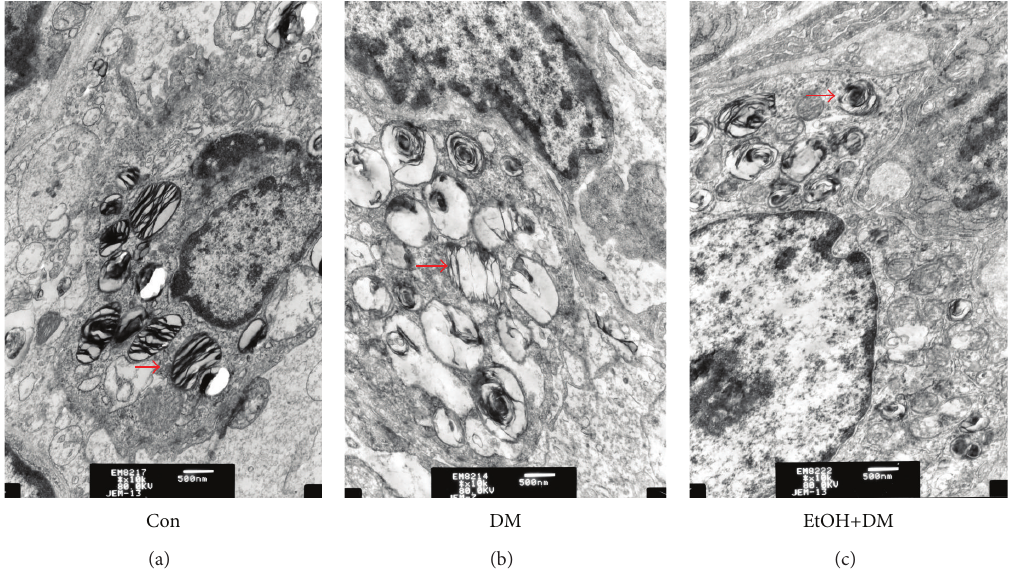
Figure 3: Transmission electron microscopy pictures of Type II alveolar cell in different groups ( × 15K).